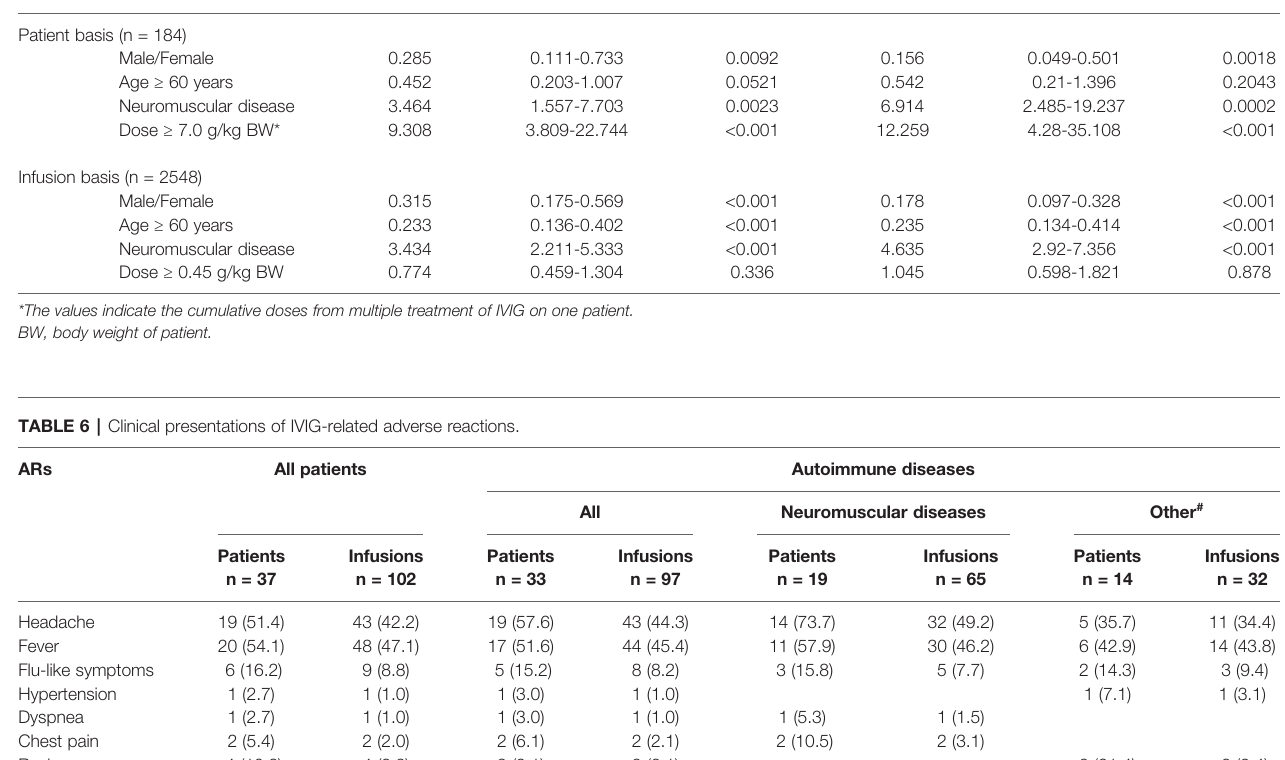
ARs, adverse reactions. All table values are n (%). # Other of autoimmune diseases are those without neuromuscular